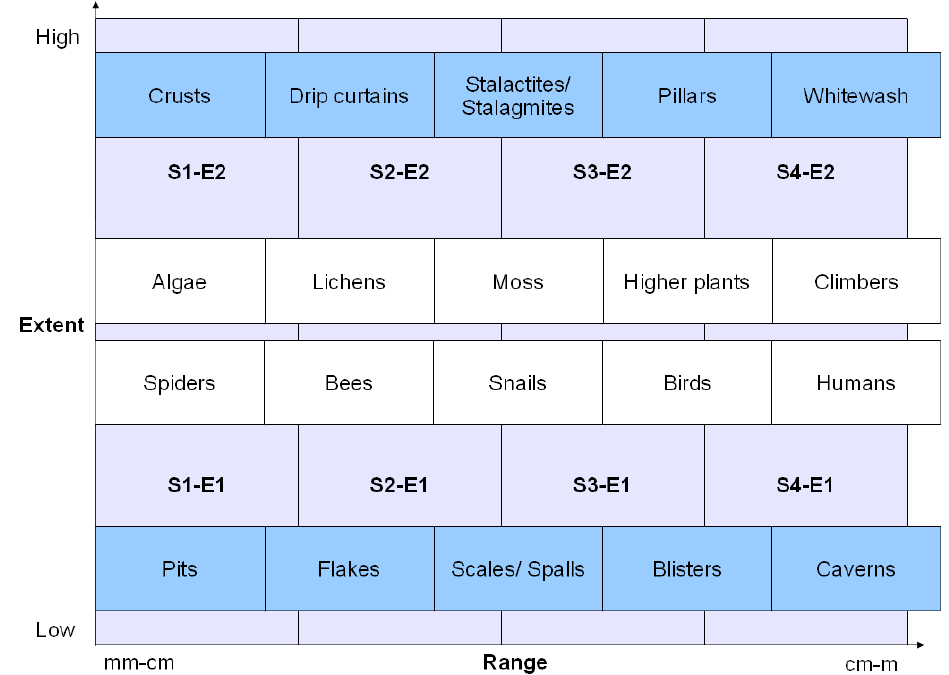
Figure 1. Size-extent (S-E) index used in the classification of weathering